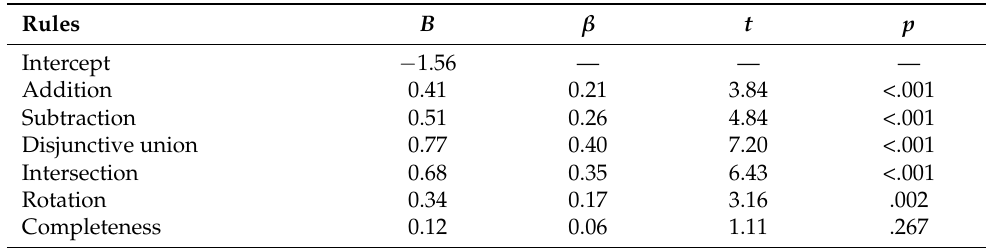
Table 3. Item difficulty